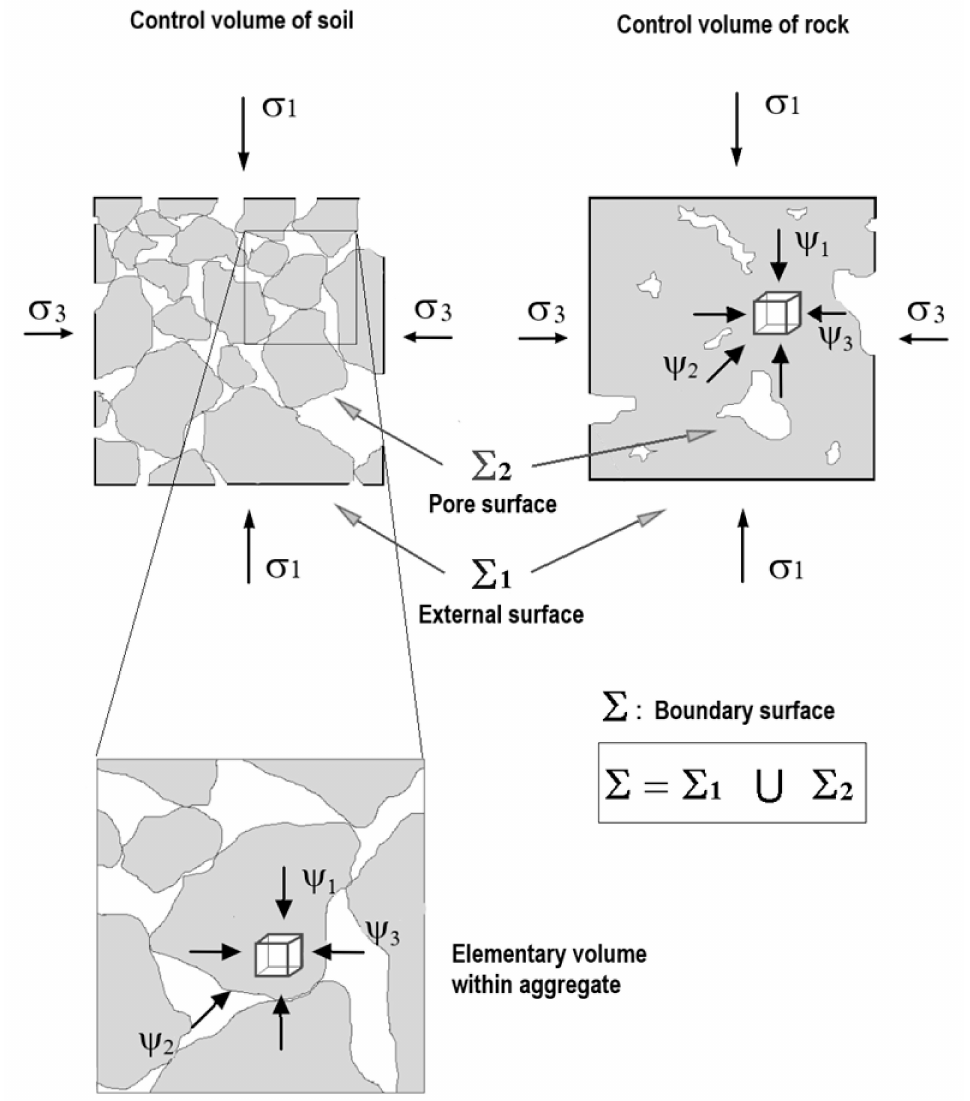
Figure 1. Control volumes of soil and rock. The elastic problem considers here elementary volumes smaller than pores; the stress σ ij , acting over the control volume, should be viewed as boundary condition for the elastic problem having as unknown the stress field ψ ij . Note that the boundary surface is given by union of pore and outer